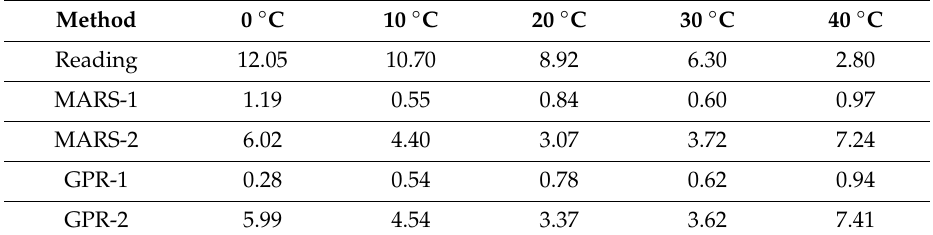
Table 6. The root mean square error (RMSE) in percentages at various temperatures on sensor C.